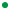
Neutrophil phagocytosis and responsiveness to a bacterial stimulus.(A-J) Neutrophil responsiveness to fMLF in healthy controls (n = 6) and patients with fragile neutrophils (n = 9). Responsiveness of neutrophils was defined as (MFI [AU] sample with fMLF) / (MFI [AU] sample without fMLF) for all receptors except for CD62L. CD62L is shed after stimulation with fMLF, and responsiveness was therefore defined as (MFI sample without fMLF) / (MFI sample with fMLF). (K) Percentage of GFP-positive neutrophils in healthy controls (n = 6) and patients with fragile neutrophils (n = 6) after incubation with S. Aureus-GFP. (L) GFP MFI of GFP-positive neutrophils after incubation with S. Aureus-GFP. Healthy controls are depicted in green (●) and patients with fragile neutrophils in red (∎). Data are presented as scatter plot with median. Patients with fragile neutrophils were compared to healthy controls with the use of a Mann Whitney U test. MFI = median fluorescent intensity, fMLF = N-formyl-methionyl-phenylalanine. S. Aureus = Staphylococcus Aureus, GFP = Green fluorescent protein, AU = arbitrary units, MOI = multiplicity of infection. *P < 0.05.